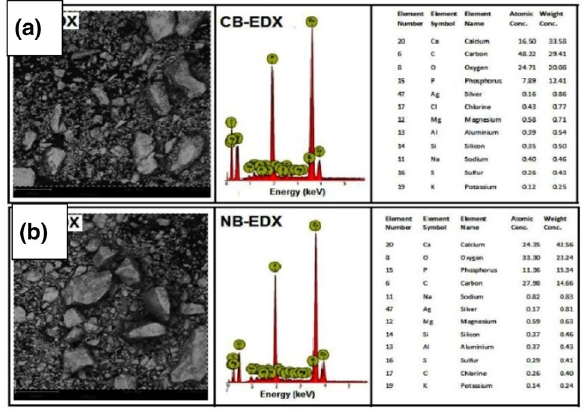
Fig. 13 SEM/EDX of HAp for a CB and b NB [45]